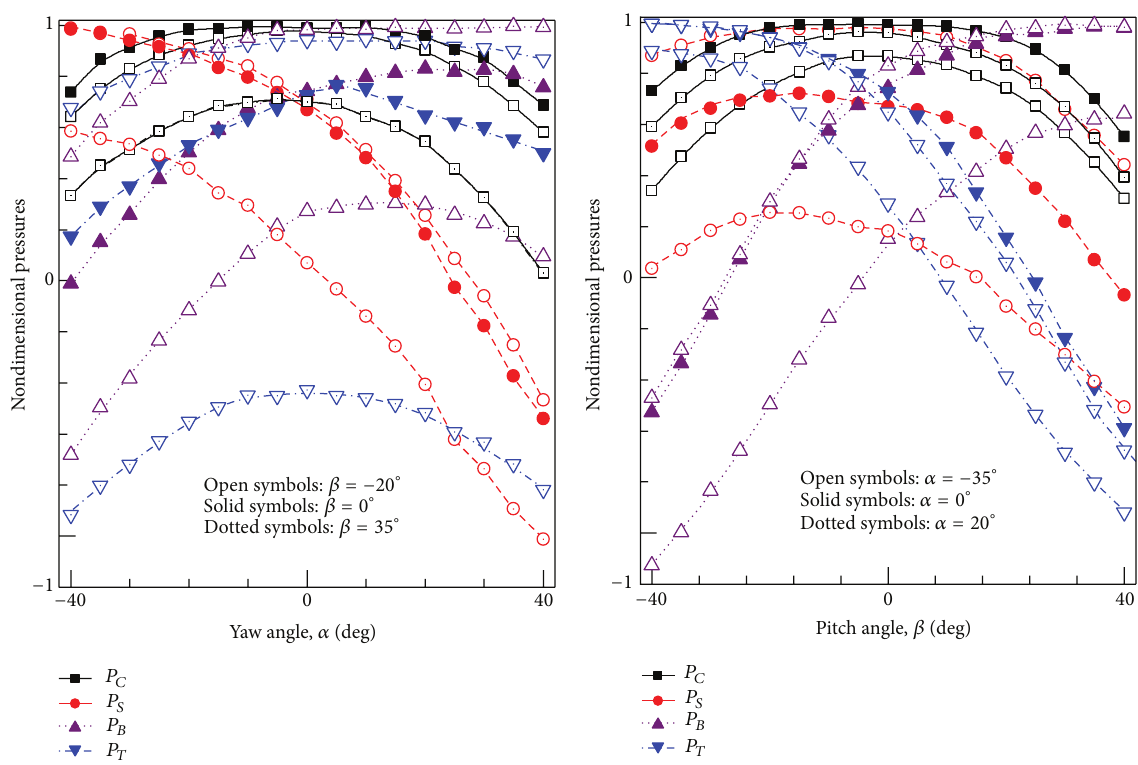
Figure 4: Sample